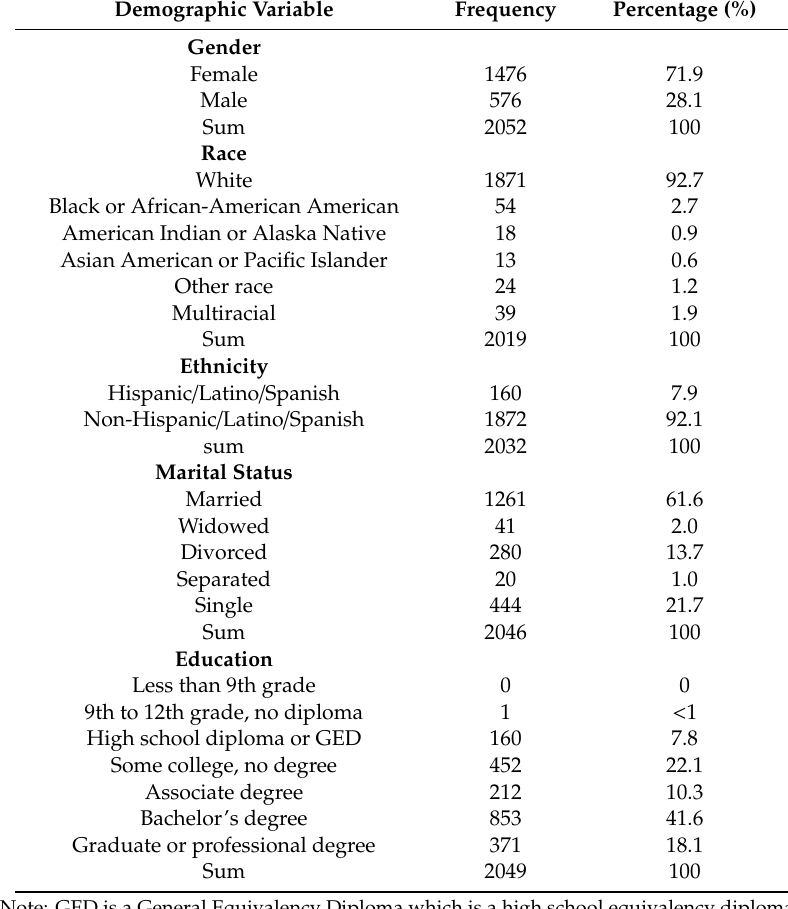
Table 2. Participant demographics.